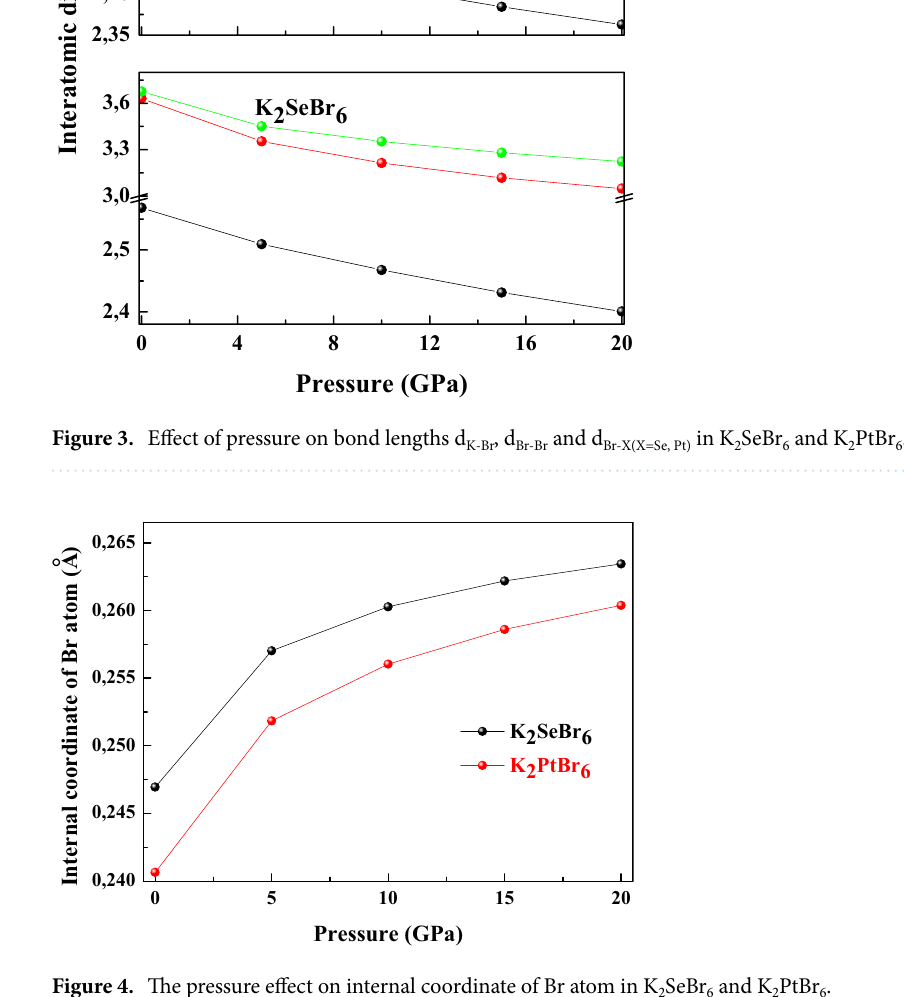
Figure 4. The pressure effect on internal coordinate of Br atom in K 2 SeBr 6 and K 2 PtBr 6